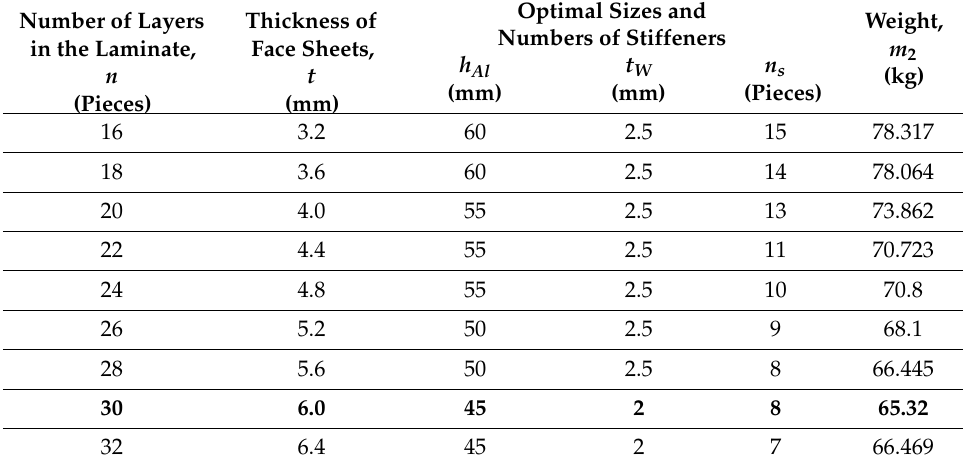
Table 5. Result of the weight optimization.